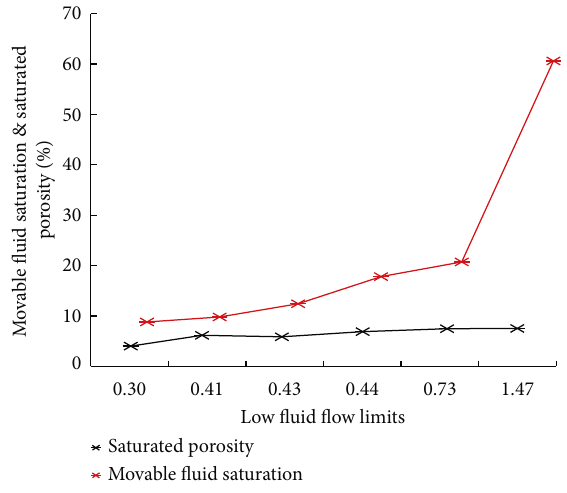
Figure 9: Evolution curves of low fl uid fl ow limits.